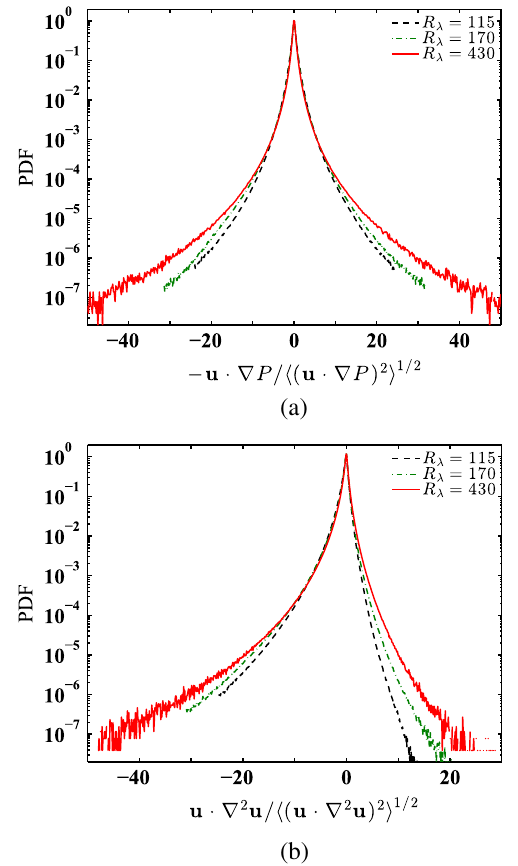
FIG. 6. PDFs of (a) − u · ∇ P and (b) ν u · ∇ 2 u normalized by their standard deviations in 3D flows. The Reynolds numbers are R ¼ 115 , 170, and 430. The PDFs of both quantities exhibit λ heavy tails. The asymmetry of − u · ∇ P is very weak (the magnitudes of the skewness of the distributions are smaller than ∼ 0 . 15 ). In contrast, the PDFs of ν u · ∇ 2 u are highly asymmetric, with skewness of approximately − 4